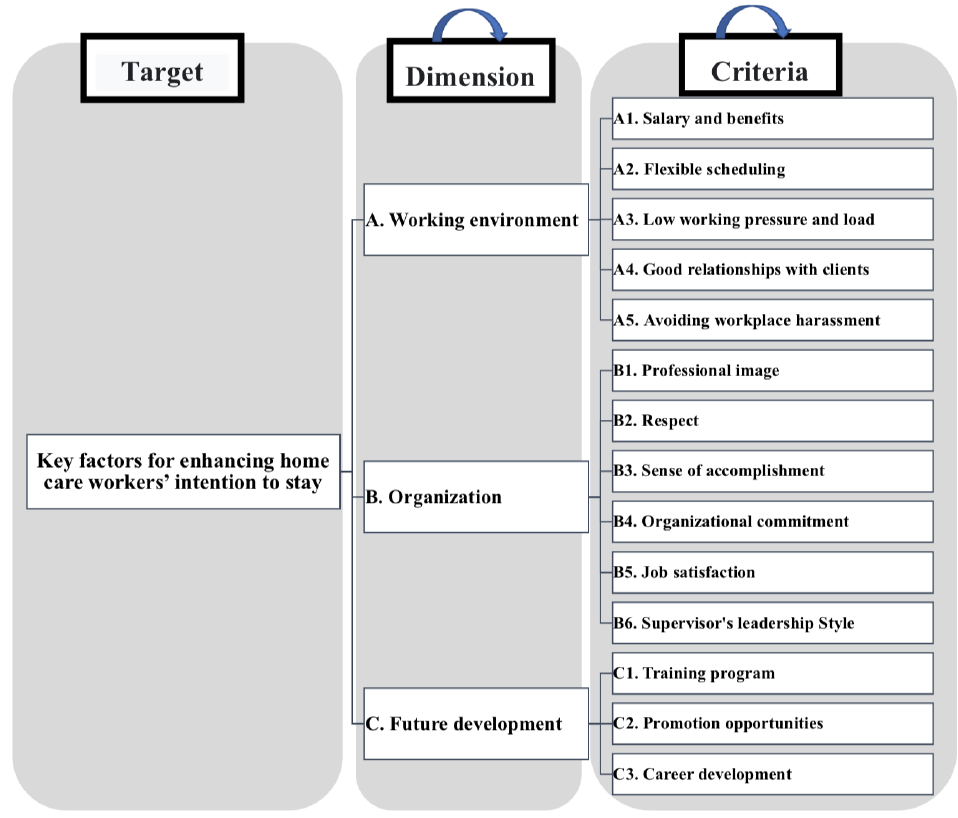
Figure 1. ANP-based model for enhancing home care workers’ intention of to stay.